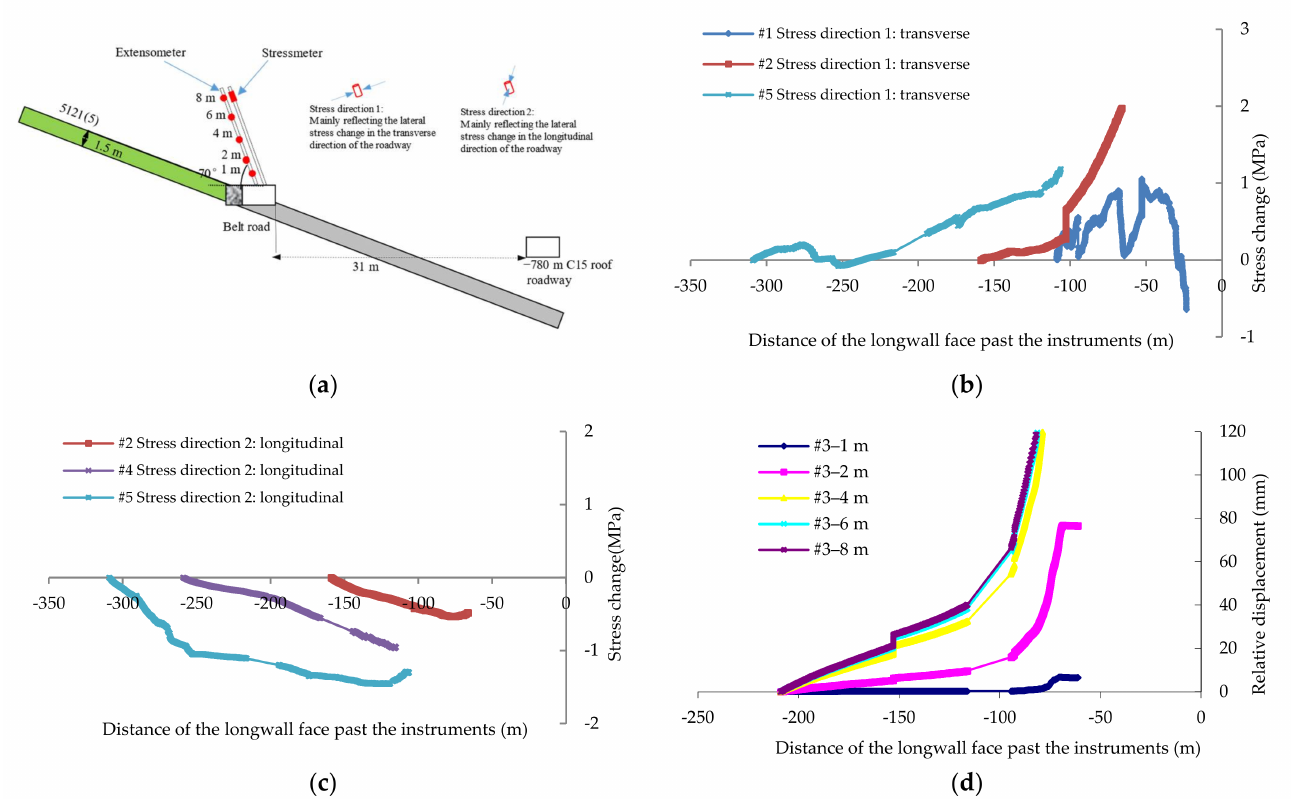
Figure 3. The key results from the belt road of LW 5121(5): ( a ) location of the instruments; ( b ) stress change in the longitudinal direction of the roadway; ( c ) stress change in the transverse direction of the roadway; ( d ) relative displacement monitored by extensometer